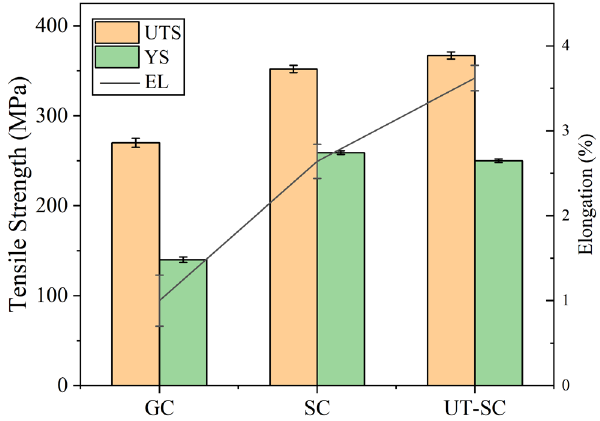
Figure 9. Tensile properties of alloys with different processes in as-cast state.